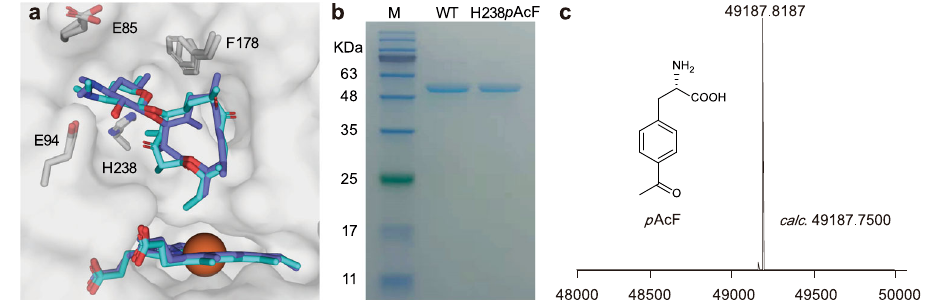
Fig. 2 | Design and preparation of PikC H238 p AcF . a Overview of the superimposed PikCactivesiteswithproductivebindingof 4 and 5 (PDBIDcodes:2VZ7and2VZM). Thehemegroupandaminoacidresiduestargetedformutagenesisaredisplayedas sticks.Substrates 4 and 5 areshowninslateandcyan,respectively.Theironatomis shown as sphere. b SDS-PAGE analysis of puri fi ed PikC WT and PikC H238 p AcF . Source